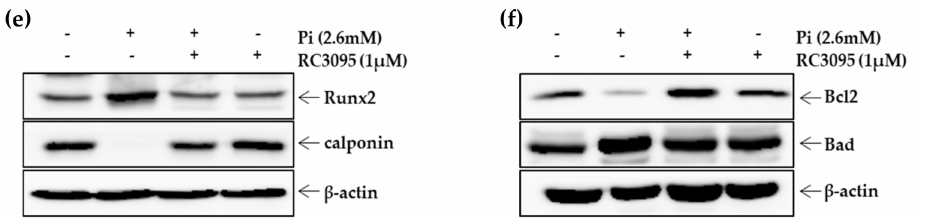
Figure 4. E ff ect of RC-3095 on Pi-induced vascular calcification in cultured explants of aorta. Pieces of rat aorta were cultured in calcification medium (2.6 mM) for 10 days. ( a ) The calcified lesions were examined by von Kossa and ARS staining (left). Scale bar: 50 µ m. The percent calcified area was calculated using Calcification Analyzer Ver2 (right). * p < 0.01 vs. control. ( b and c ) Levels of GRP or GRP-R proteins and their mRNA were estimated by western blot analysis and real-time RT-PCR, respectively. * p < 0.05; ** p < 0.01 vs. control. Pieces of rat aorta were incubated in calcification medium (2.6 mM) in the presence or absence of RC-3095 (1 µ M) for 10 days. ( d ) The calcified lesions were examined by von Kossa staining (left). Scale bar: 50 µ m.The percent calcified area was calculated using Calcification Analyzer Ver2 (right). * p < 0.01 vs. control, # p < 0.01 vs. 2.6 mM Pi, Data shown